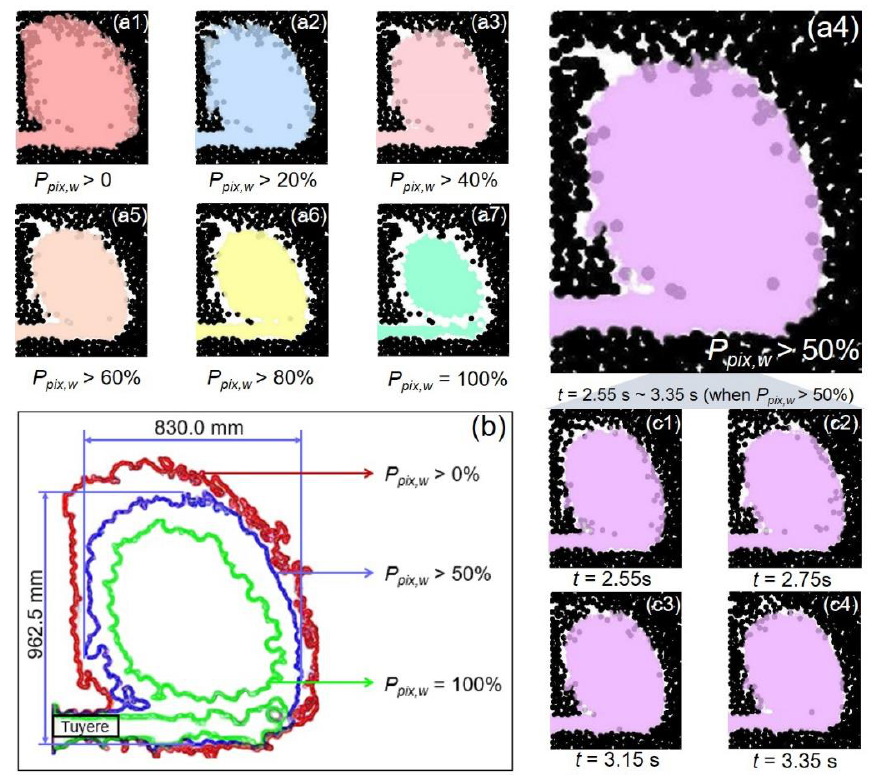
Figure 5. ( a1 – a7 ) In v inlet = 168 m / s, the comparisons between binary image of the void when t = 2.95 s and images for which P pix,w > 0%, P pix,w > 20%, P pix,w > 40%, P pix,w > 50%, P pix,w > 60%, P pix,w > 80% and P pix,w = 100%, respectively. ( b ) Boundary and void area size when P pix,w > 0, P pix,w > 50% and P pix,w = 100%. ( c1 – c4 ) Comparison of determined void area ( P pix,w > 50%) with DEM results obtained at t = 2.55 s, 2.75 s, 3.15 s and 3.35 s.